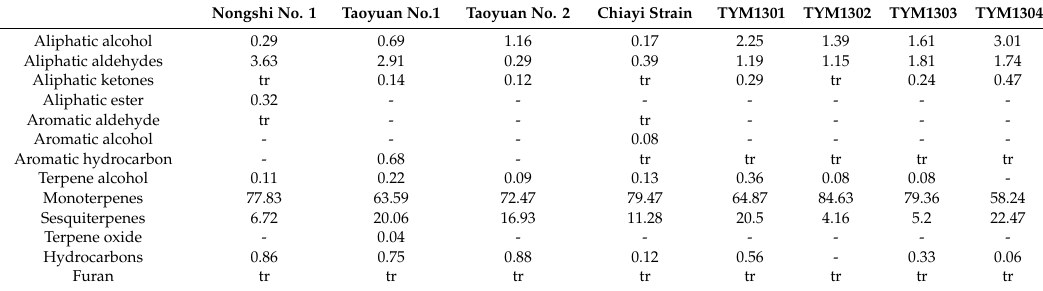
Table 5. Percentages of extracted chemical groups of Hsian-tsao analyzed using